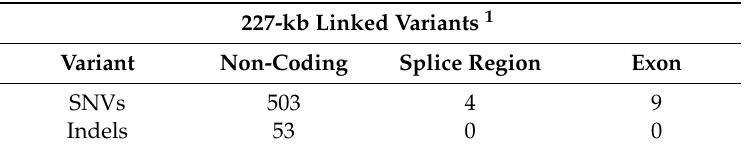
Table 3. Sequence variants identified from the capture array sequencing of 227 kb of GGA 12 from UCD Wingless-2.331 line individuals. Categories of variants were single-nucleotide variants (SNVs) and insertions or deletions (indels). Non-coding variants are those found in an intron, 5000 bases up- or down-stream of a gene, intergenic spaces (greater than 5 kb from a gene), or in a non-coding transcript. Predicted splice region variants are within 1–3 bases of the exon or 3–8 bases of the intron, and exonic variants are found in an exon of a protein coding